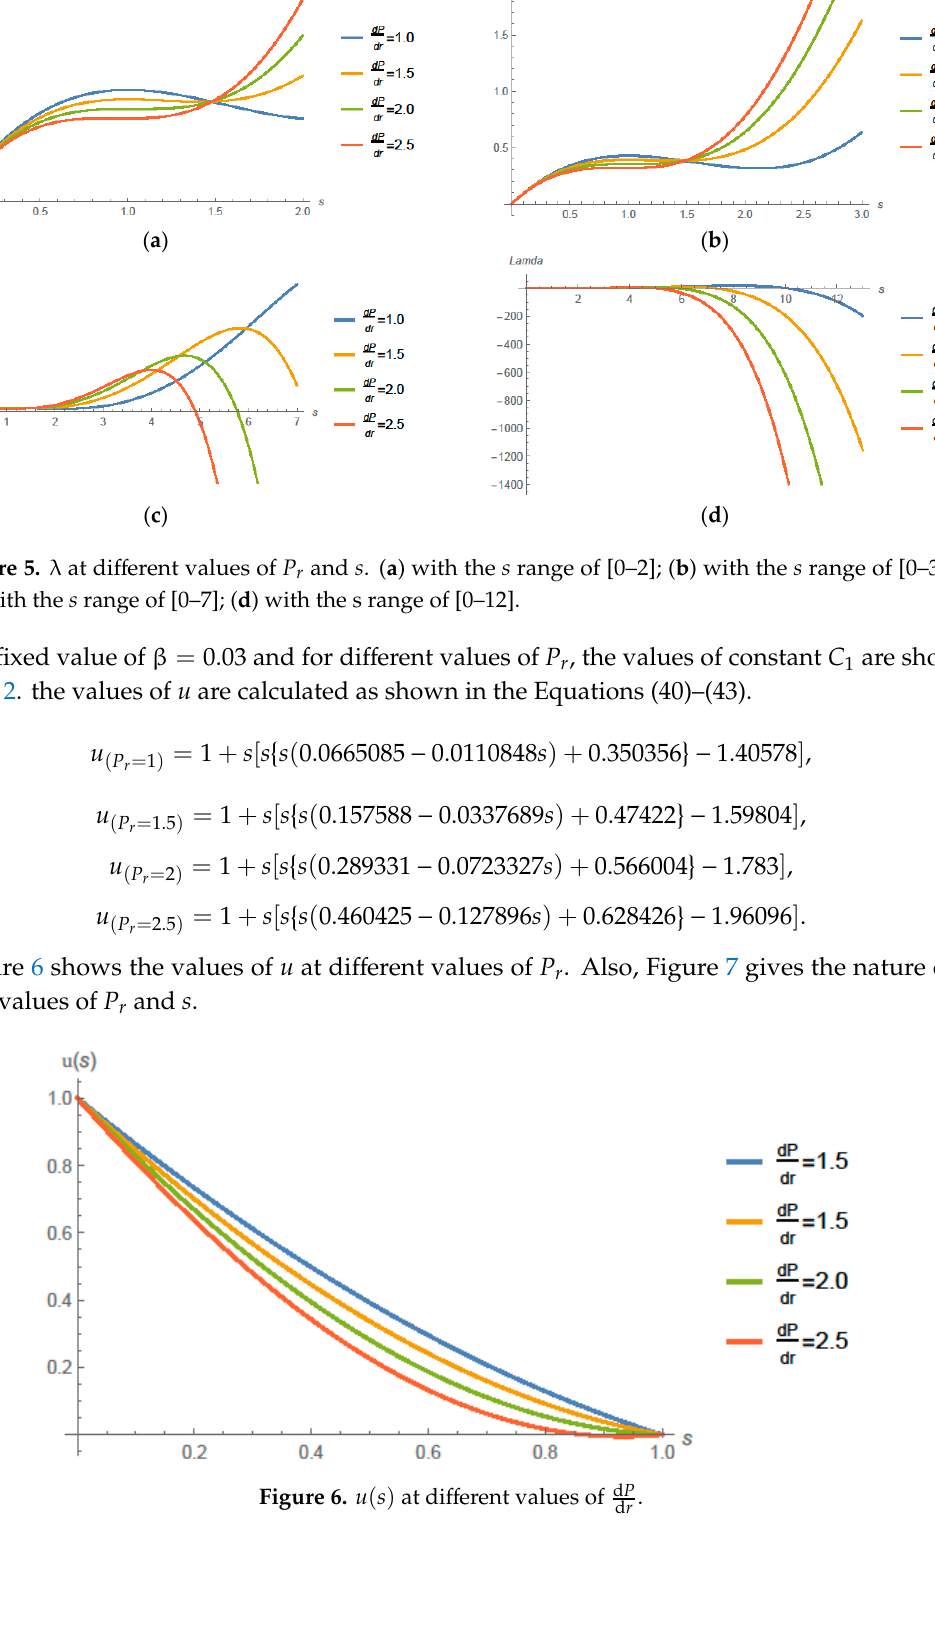
. (cid:2914)(cid:3045)